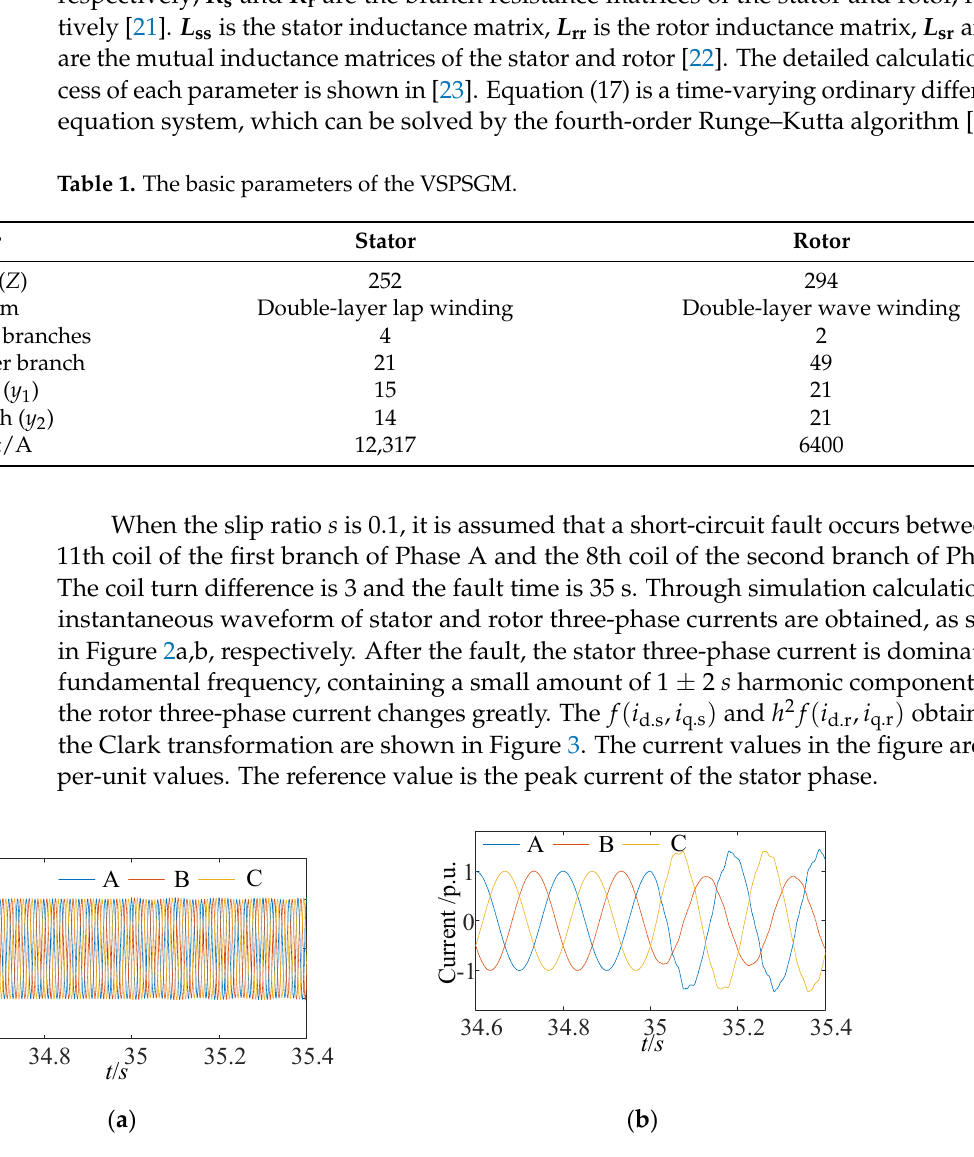
Figure 3. f ( i d.s , i q.s ) and h 2 f ( i d.r , i q.r ) obtained by Clark transform . The simulation results in Figure 3 are consistent with the analysis results. After the fault occurs,